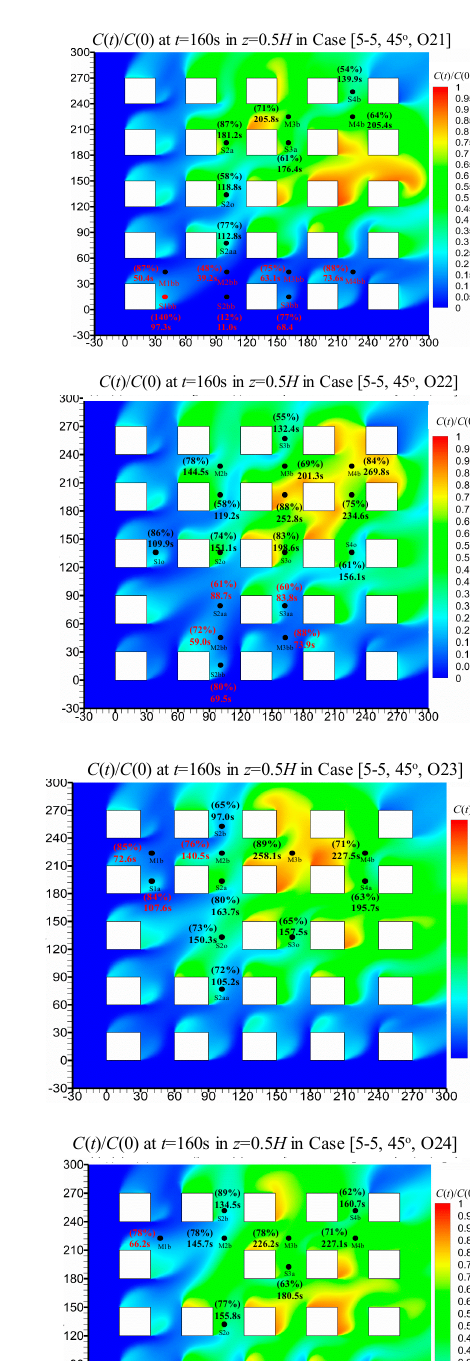
Figure 8. ( a ) 3D streamline in Case [5-5, 45 ◦ , O21] and Case [5-5, 45 ◦ , O33]; ( b ) the net ACH in all 24 test cases. ( c,d ) C(t)/C(0) at t = 160 s, age of air at various points, and normalized velocity at z = 0.5 H in Case [5-5, 45 ◦ ] and Case [5-5, 45 ◦ , Oij].